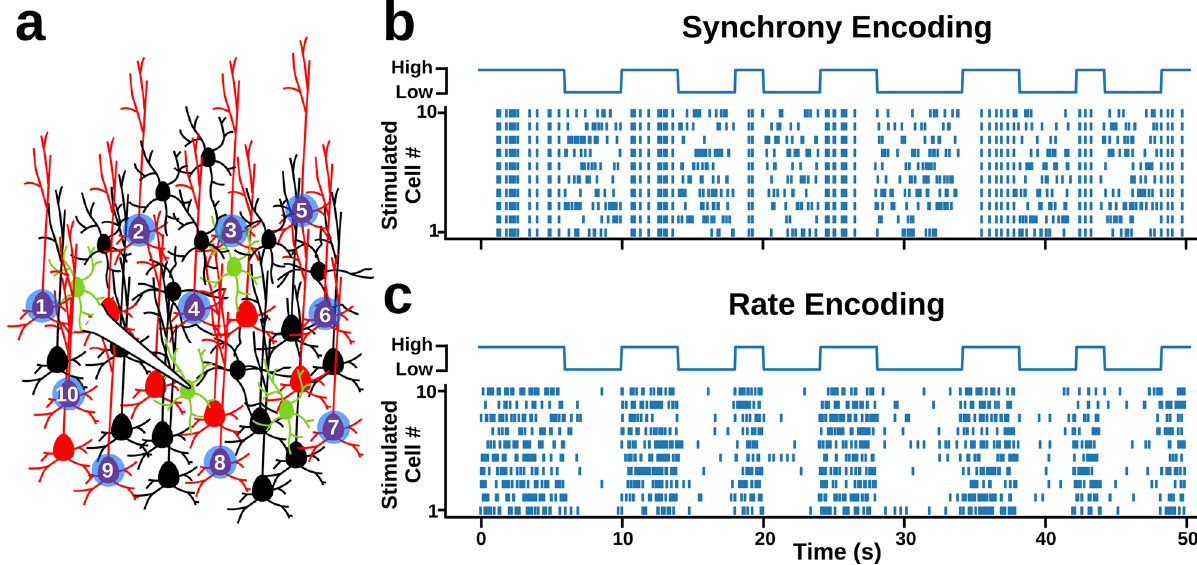
Fig. 3 Arti fi cially encoding a random 1-bit signal using the synchrony or rate of optical inputs to ChR2 + pyramidal neurons in layer 2/3. a Experimental protocol. b Sample raster plots illustrating how the 1-bit signal was encoded using synchrony of optical inputs. c Sample raster plots illustrating how the 1-bit signal was encoded using the rate of optical